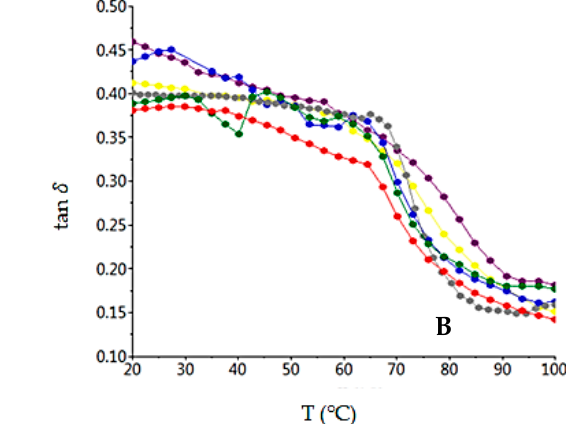
Figure 2. Evaluation with temperature of the G ′ values (open symbols), G ′′ (solid symbols) ( A ) and tan δ ( B ) for the samples with different levels (- ● -0%; - ● -5%; - ● -10%; - ● -15%; - ● -20%; - ● -25%) of germinated bean flour additions.